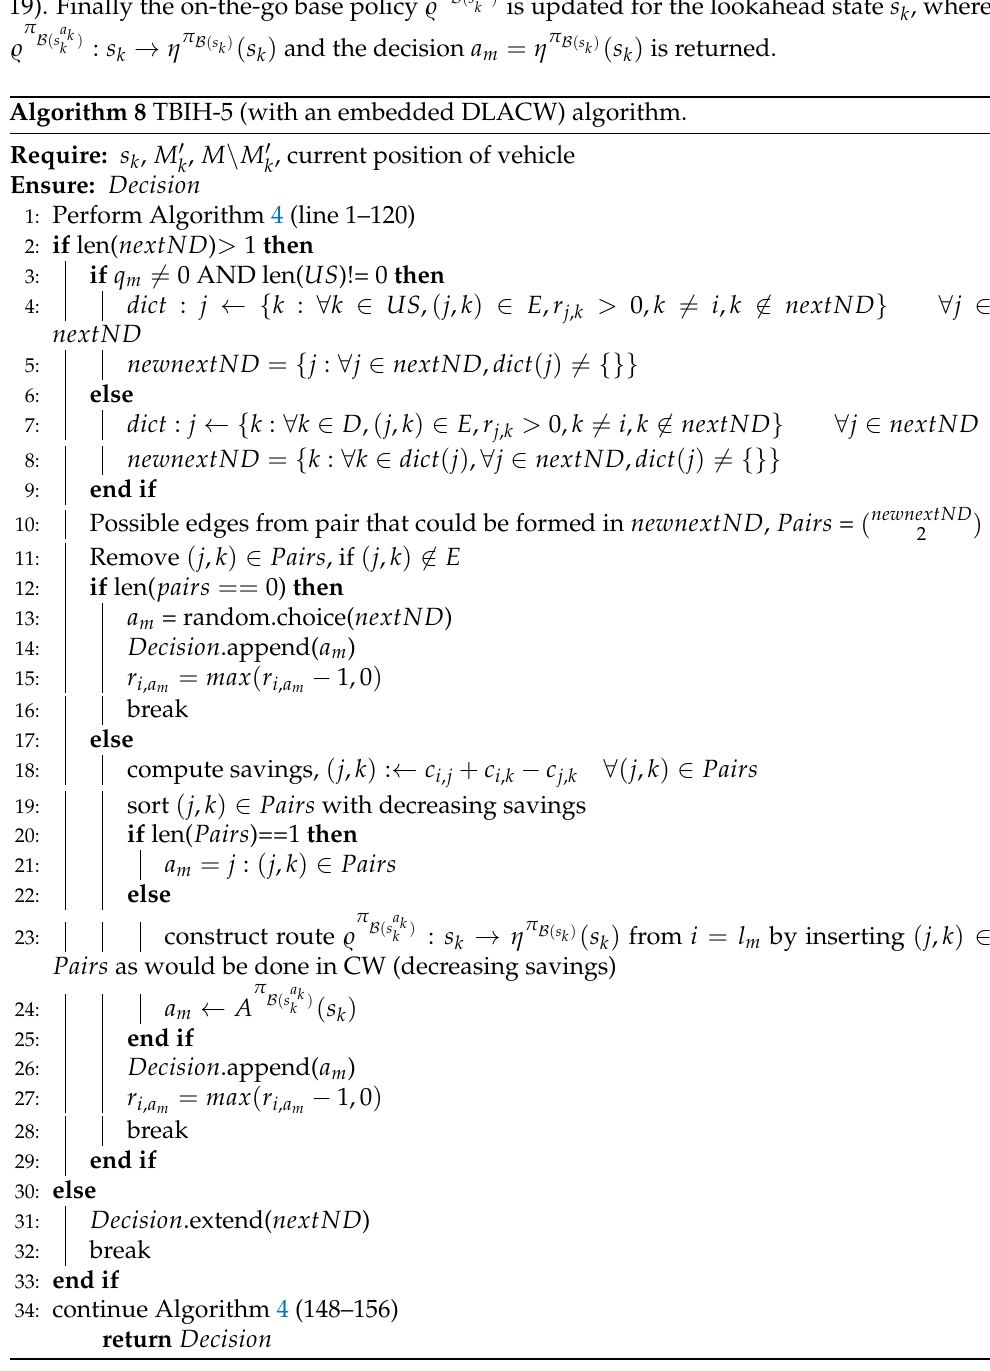
The algorithm for TBIH-5 is presented in Algorithm 8. Similar to Algorithm 5, Algorithm 6 is extended ,resulting in a different base heuristic. When compared to Algorithm 6, some parts of this algorithm consist of detecting the potential next destination j of vehicle m that might lead to either a shelter of depot, depending on the current capacity status q m (lines 3–9). Through this mechanism, the possible option for j is restricted to only those ideally more guided destinations. Edges are detected (line 10) and removed if they do not exist in the network (line 11), while savings are computed (line 18) and sorted (line π B ( sak k ) is updated for the lookahead state s 19). Finally the on-the-go base policy (cid:36) k , where